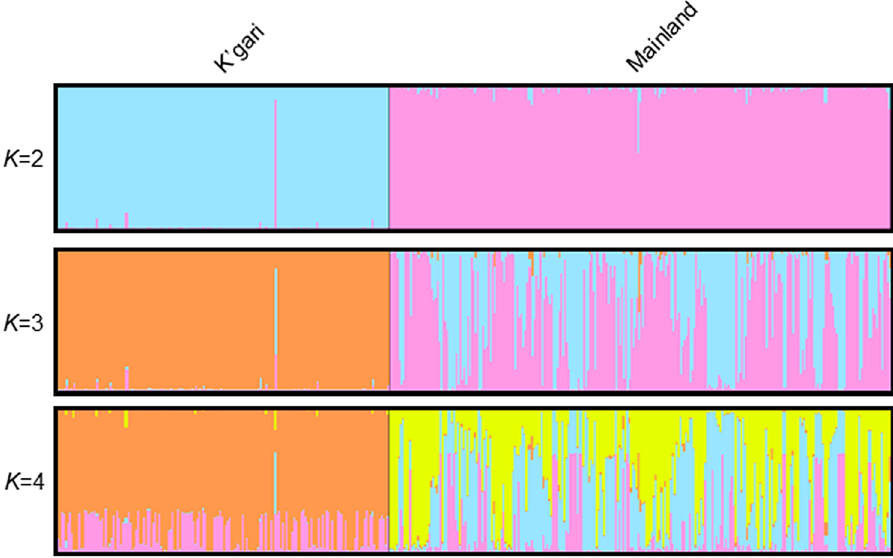
Figure 3. STRU CTU RE admixture barplots for values of K = 2–4 showing the genetic relationships between the K’gari and mainland dingo populations. K = 3 was selected as the best estimate of the number of genetic clusters following implementation of the Evanno